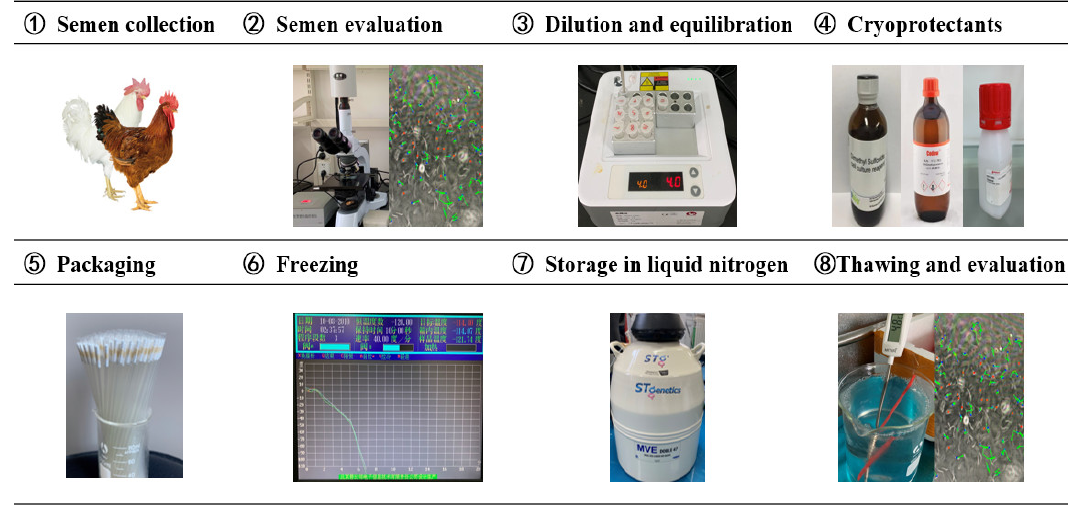
Figure 2 . Key processes of chicken sperm cryopreservation technology. Figure 2. Key processes of chicken sperm cryopreservation